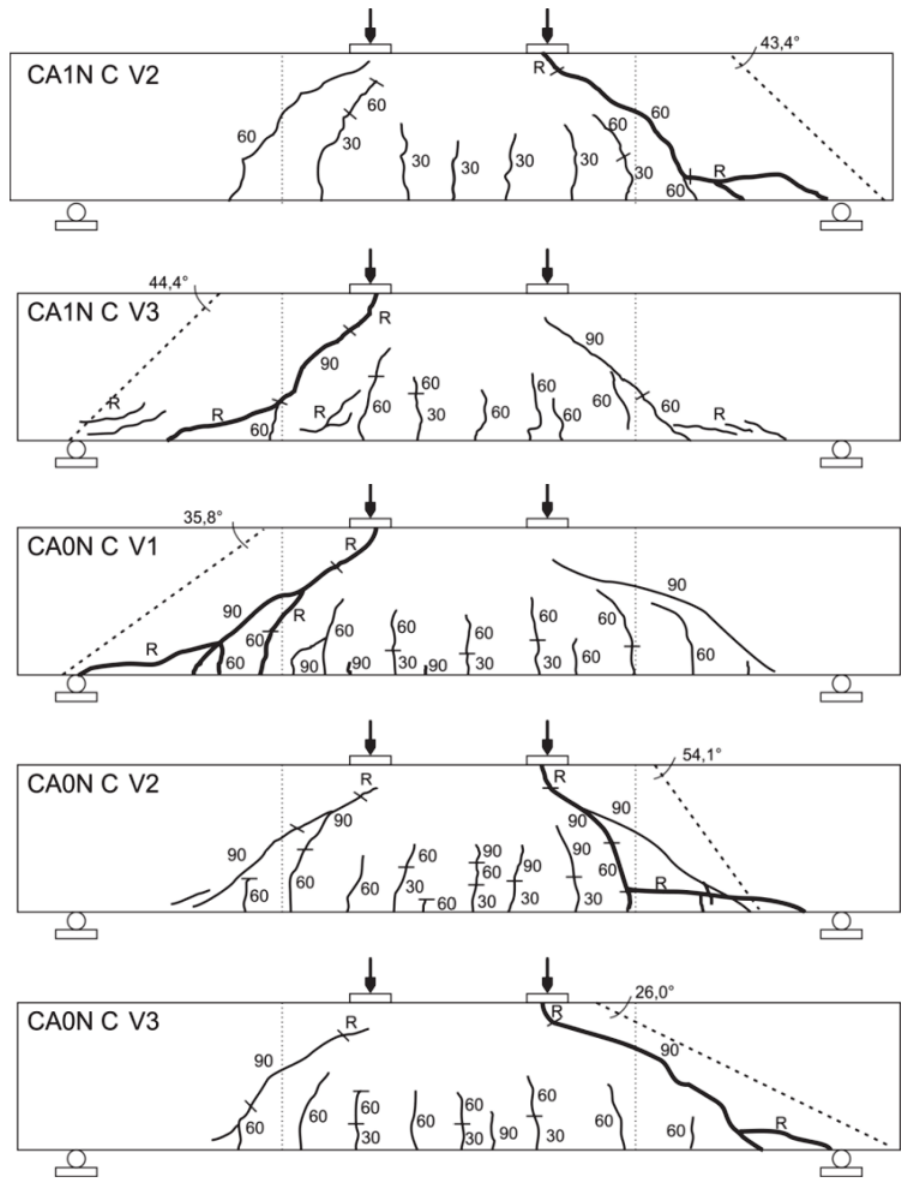
Crack patterns of self consolidating concrete beams with normal amount of coarse